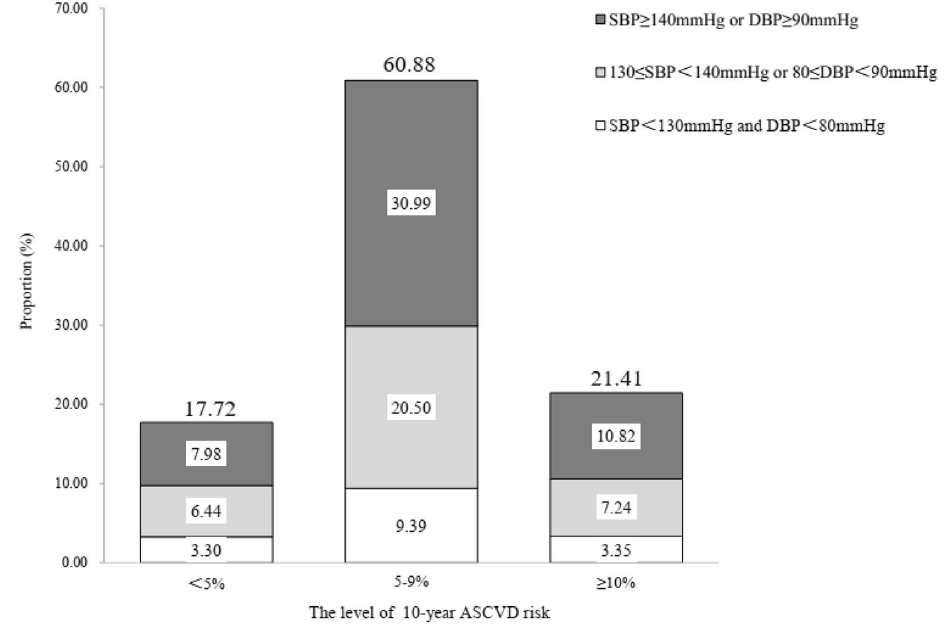
Figure 2. The 10-year ASCVD risk estimation by BP level.